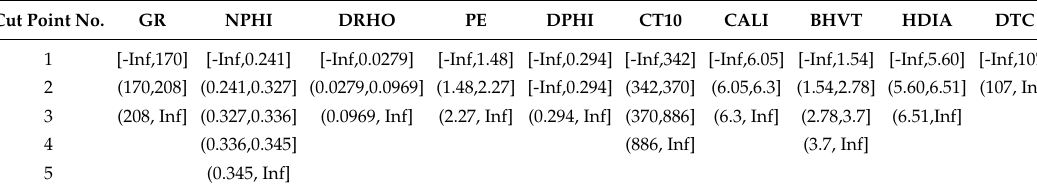
Table 2. Cut points of the